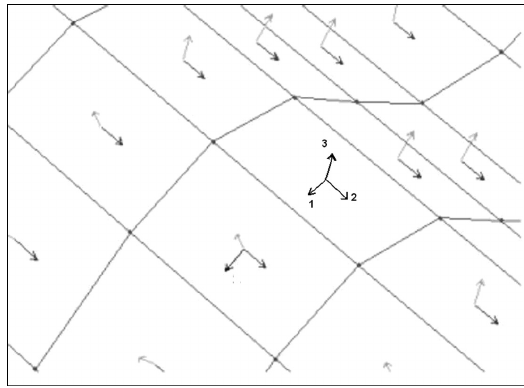
Figure 9. Orientation of the local axes of shell elements and mesh of finite elements of the